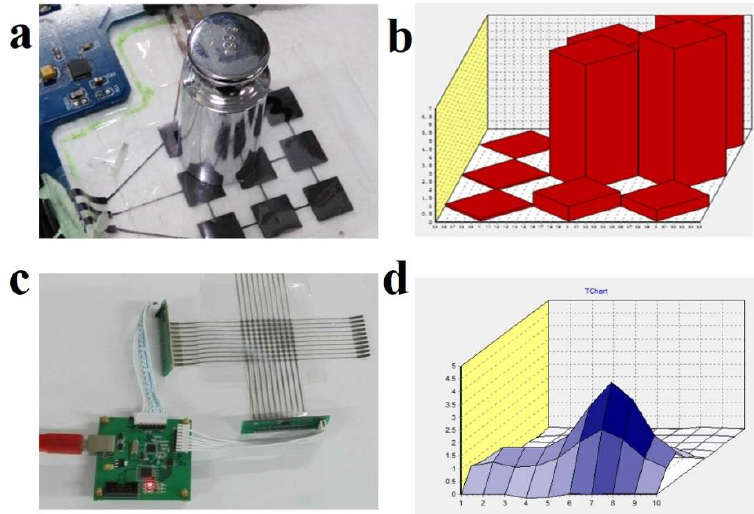
Figure 7. ( a ) The printed flexible 3 × 3 capacitive pressure sensor array and ( b ) its measurement of the 100 g weight pressure distribution; ( c ) The 10 × 10 pressure sensor array and ( d ) its corresponding testing pressure distribution map.